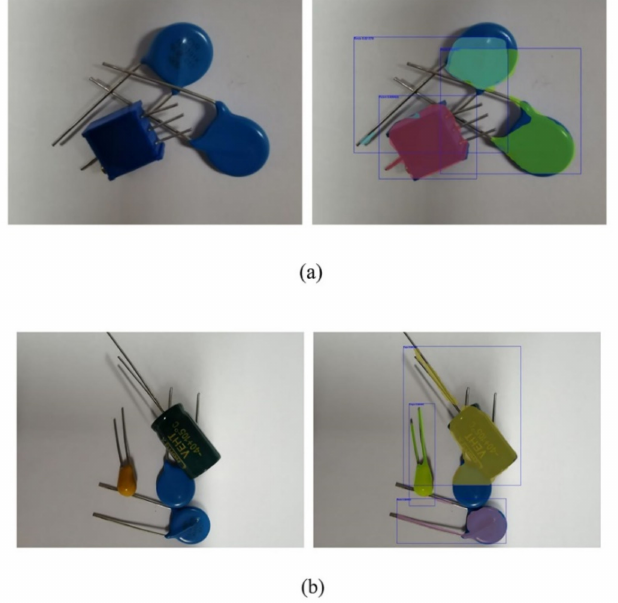
Figure 13. Electronic component segmentation in complex stacking scenarios; new testing images (left) and output of the improved Mask R-CNN (right). ( a ): detection of pins of electronic components in the case of cross placement. ( b ): the condition in which two objects are detected as